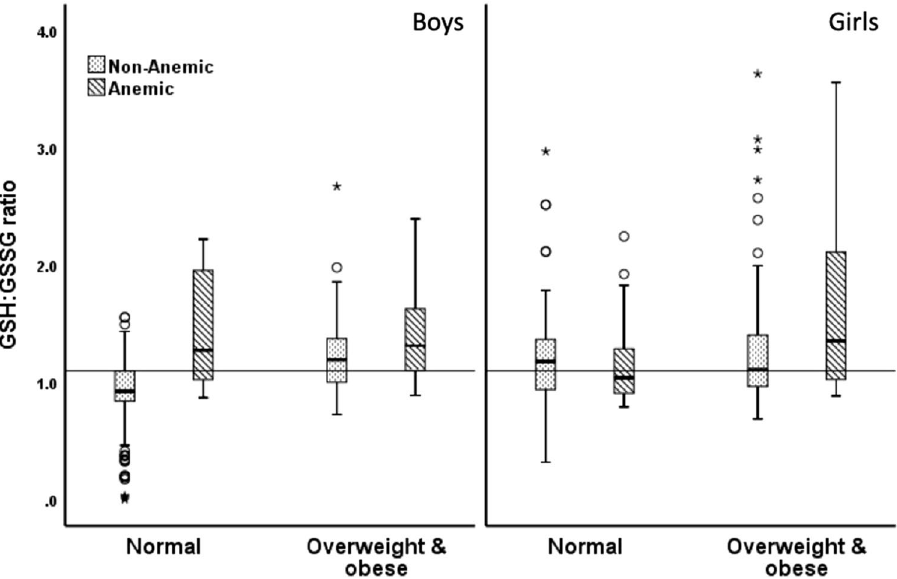
Figure 1. Reduced glutathione-to-glutathione disulfide ratio (GSH:GSSG ratio) in relation to the anemia status.